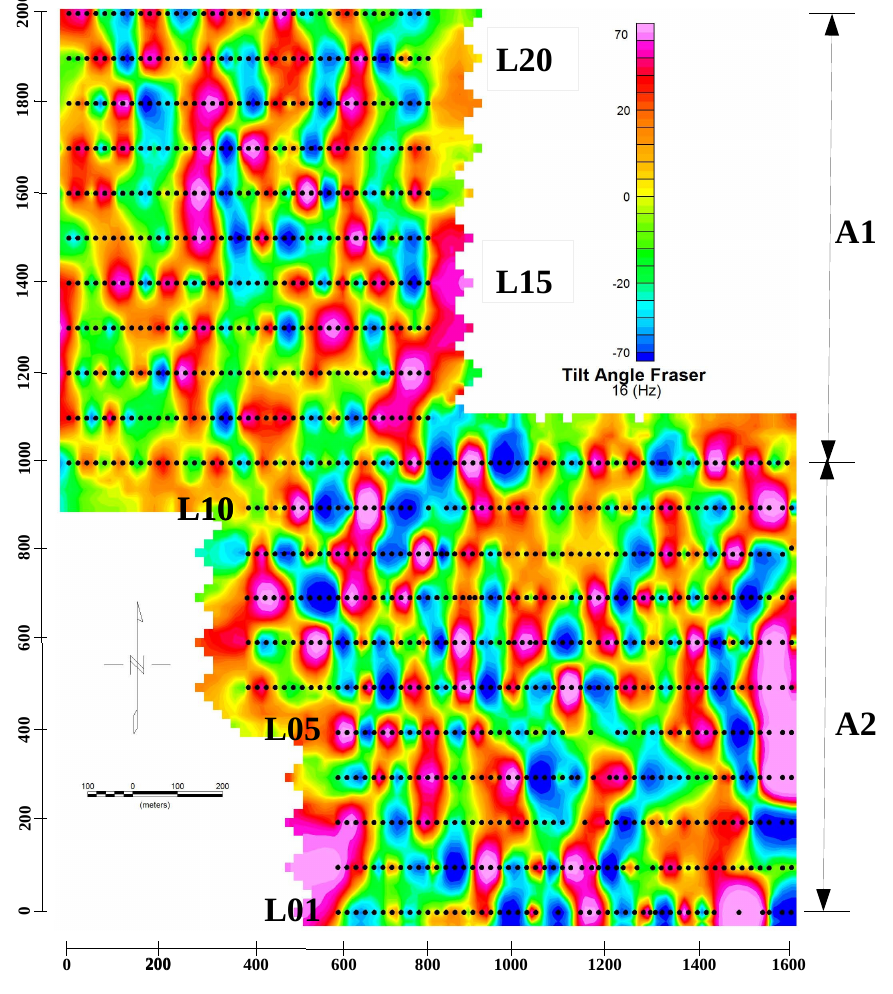
Figure 11. VLF-EM map of A1 and A2: Fraser filter applied to the tilt angle data for